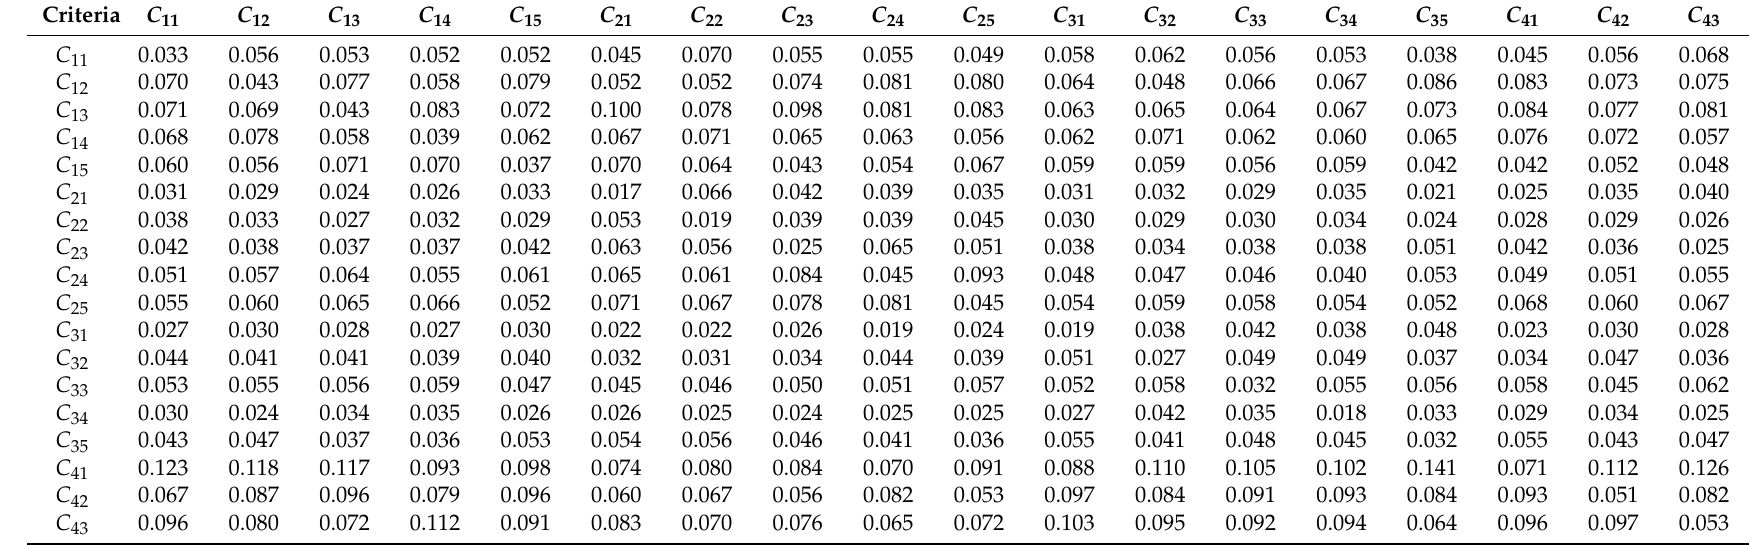
Table A6. The weighted supermatrix W .